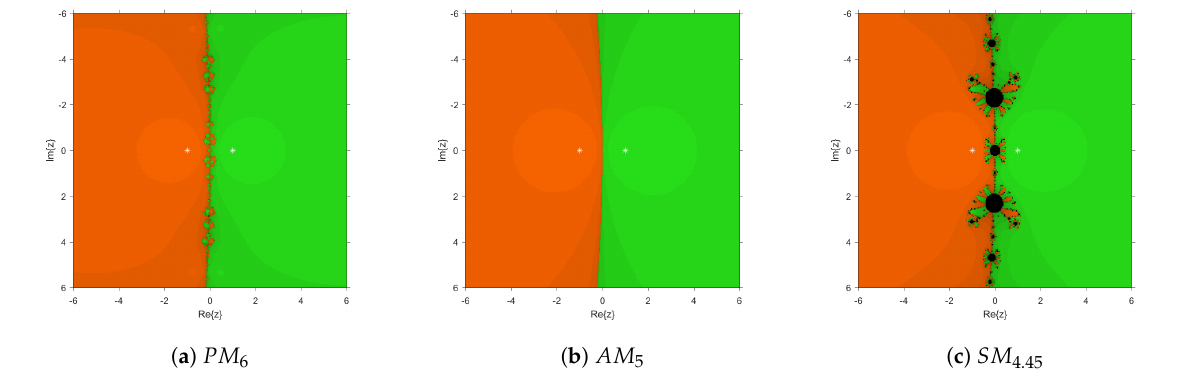
Figure 2. Complex dynamical planes of new and known methods on x 2 −